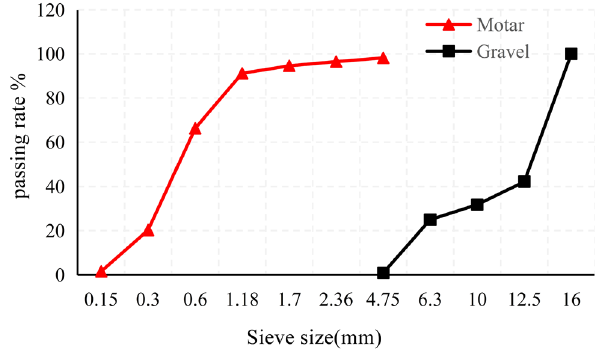
Figure 1: Particle size sieving pass